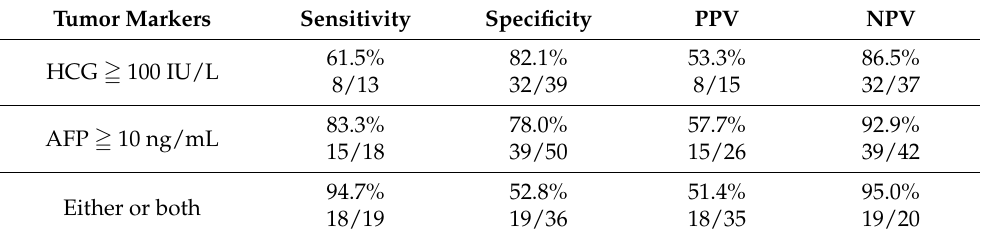
Table 2. Sensitivity, specificity, and positive/negative predictive values of tumor markers for the detec- tion of malignant non-germinomatous germ cell tumor components among cases with tumor resection. Tumor Markers Sensitivity